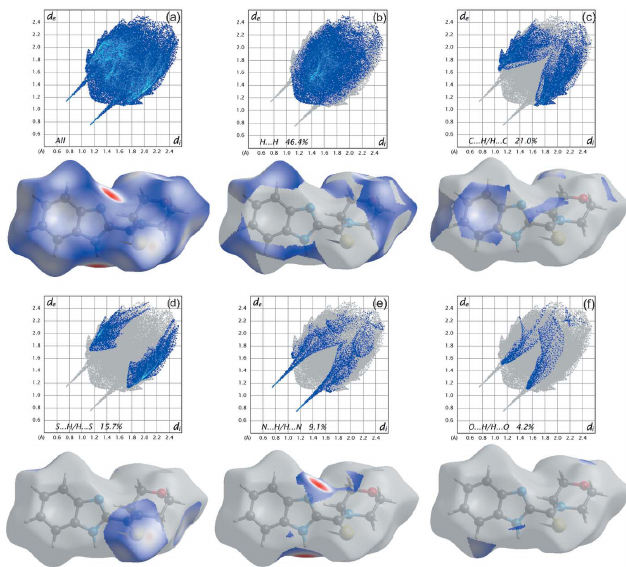
Figure 4 Two-dimensional fingerprint plots of the title compound, showing ( a ) all interactions, and delineated into ( b ) H (cid:3)(cid:3)(cid:3) H, ( c ) C (cid:3)(cid:3)(cid:3) H/H (cid:3)(cid:3)(cid:3) C, ( d ) S (cid:3)(cid:3)(cid:3) H/ H (cid:3)(cid:3)(cid:3) S, ( e ) N (cid:3)(cid:3)(cid:3) H/H (cid:3)(cid:3)(cid:3) N and ( f ) O (cid:3)(cid:3)(cid:3) H/H (cid:3)(cid:3)(cid:3) O interactions.